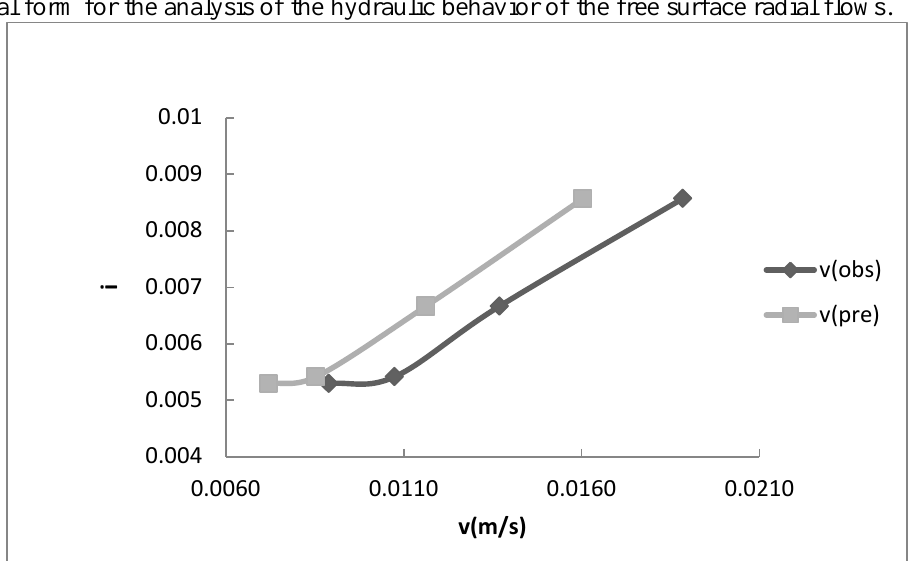
Figure 5. i-v curve for the depth of 110 cm and the levels of 20